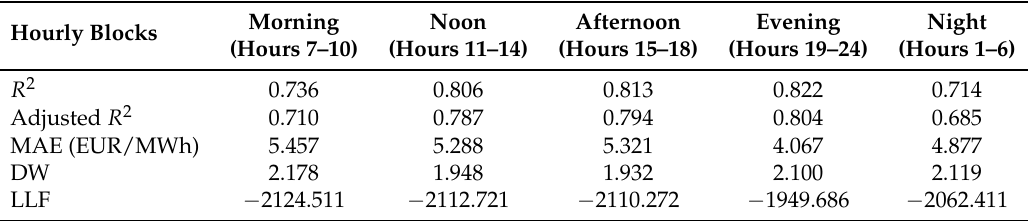
Table 8. Goodness of fit, for morning, noon and afternoon hourly blocks for weekend days, including renewable energies wind and